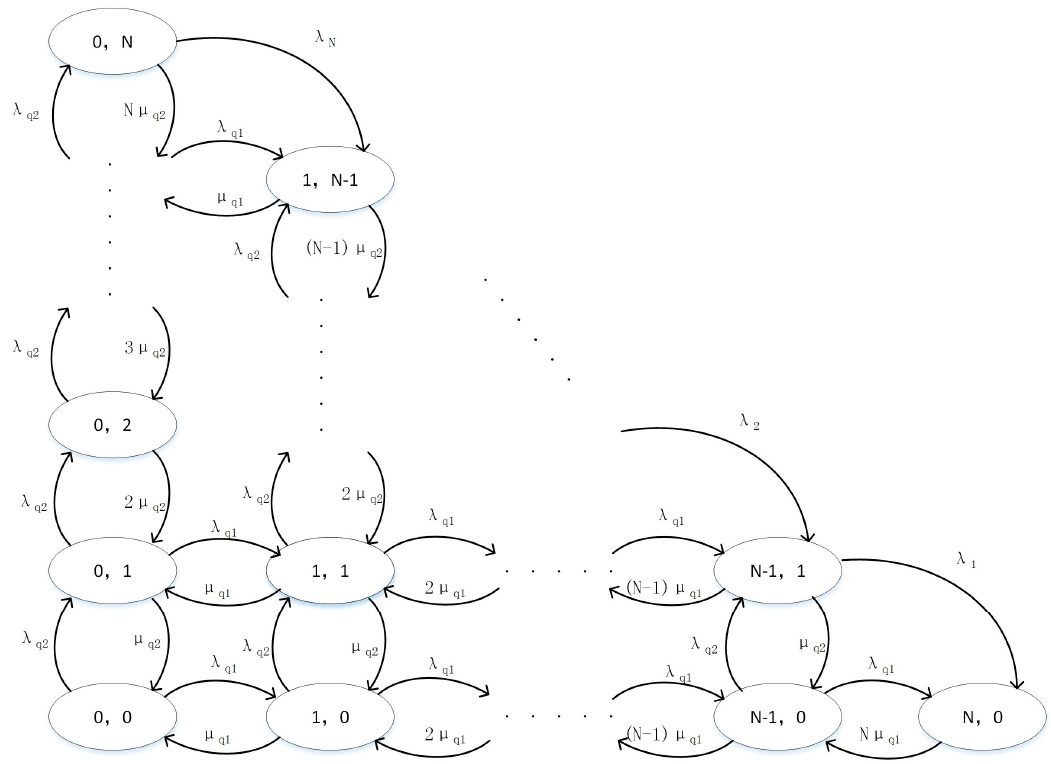
Figure 5. State transition diagram of the two-dimensional Markov chain.